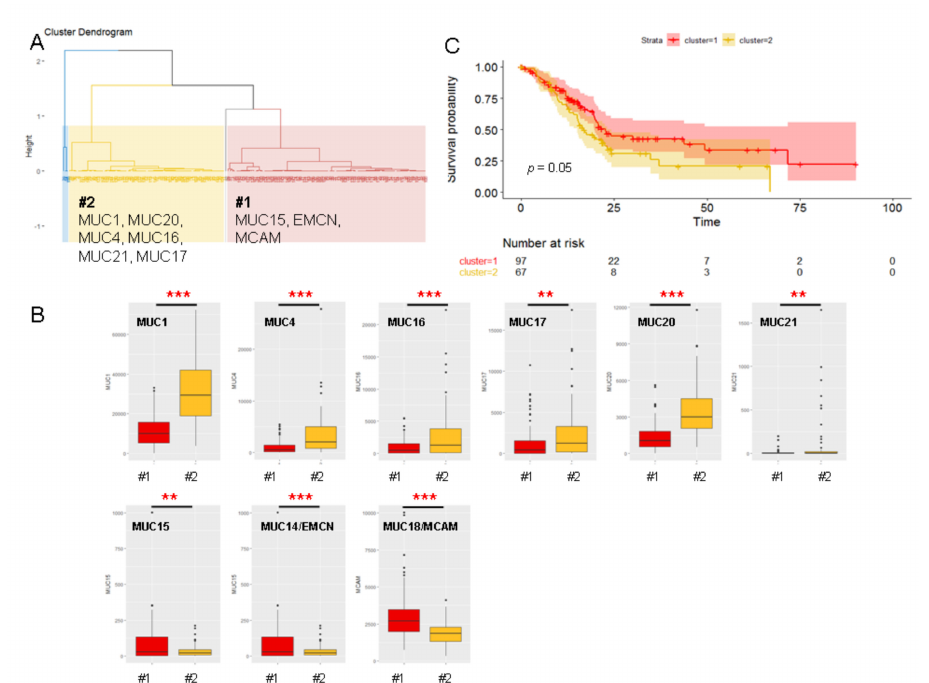
Figure 5. Unsupervised hierarchical clustering analysis of PDAC patients according to their relative mucin mRNA expression. ( A ) Mucin-based dendrogram that displays clustering analysis between patients. The dendrogram shows four hierarchical clusters according to the expression pattern of mucins. ( B ) Boxplot of mucin expression in major clusters #1 and #2. Statistical analyses were performed using an unpaired t -test (***, p < 0.001; **, p < 0.01). ( C ) Kaplan–Meier curves of clusters #1 and